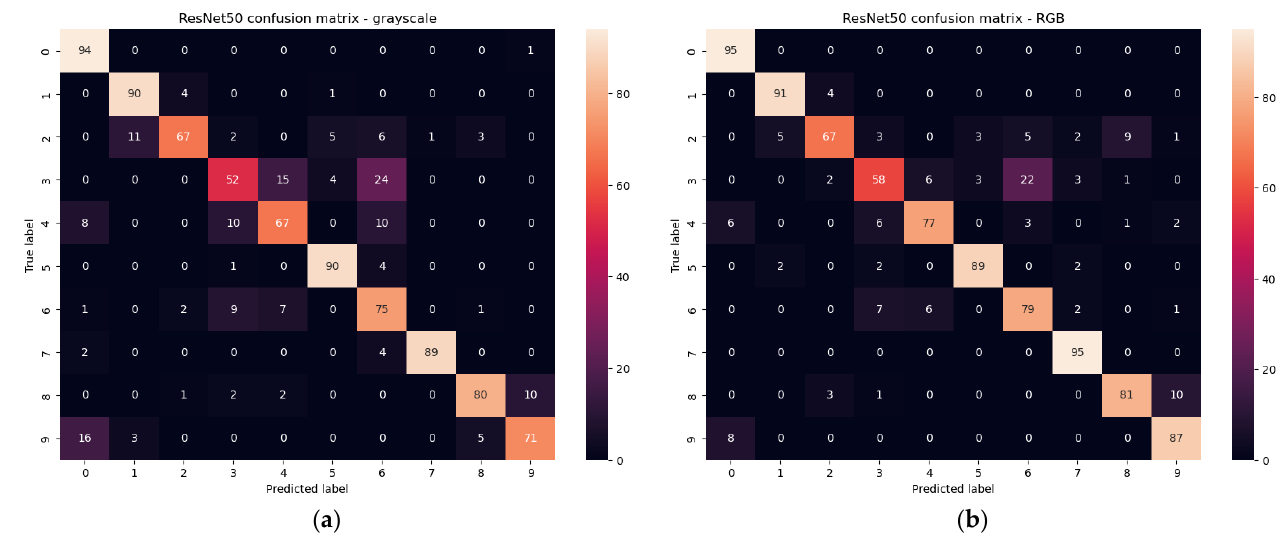
Figure 17. Confusion matrixes for test set of grayscale ( a ) and RGB ( b ) images for MobileNetV2.